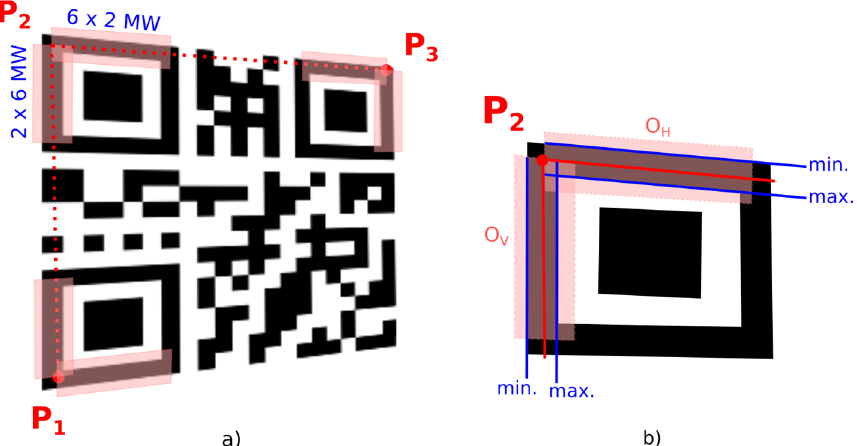
Figure 14. Refining of the position of the corner points of the QR Code (alternative 2). ( a ) areas of the finder pattern where edge projections are evaluated; ( b ) local extrema in edge projections.